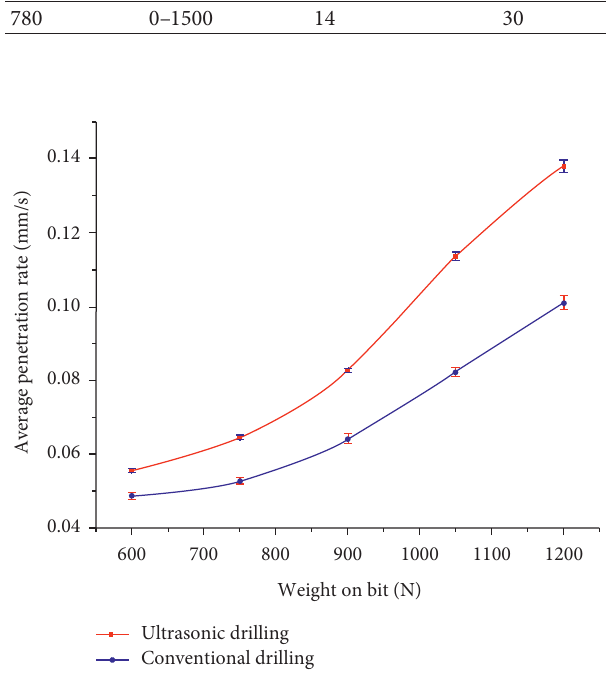
Figure 14: The relationship between WOB and average ROP.